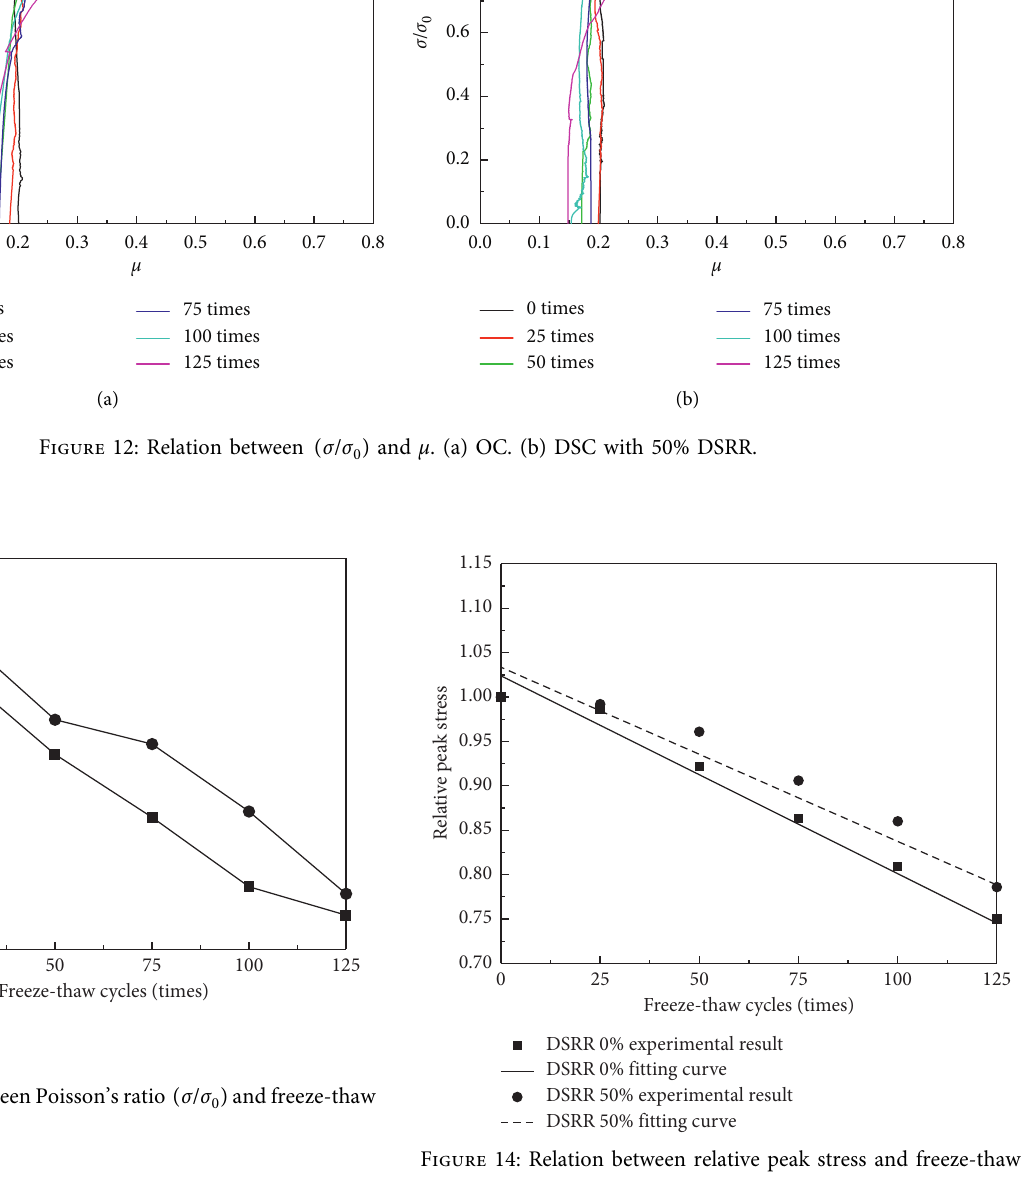
Figure 14: Relation between relative peak stress and freeze-thaw